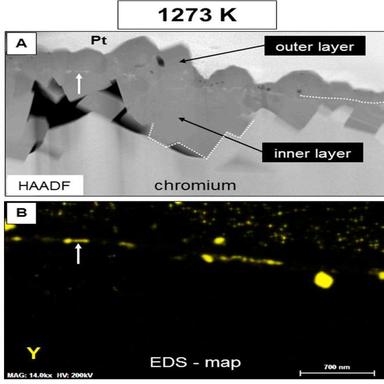
(A) - STEM-HAADF image of the scale formed on chromium implanted with yttrium ions (2 × 1016 Y/cm2 ) after 10 h of oxidation in air at 1273 K; (B) - STEM-EDS elemental distribution map of yttrium for the investigated area.